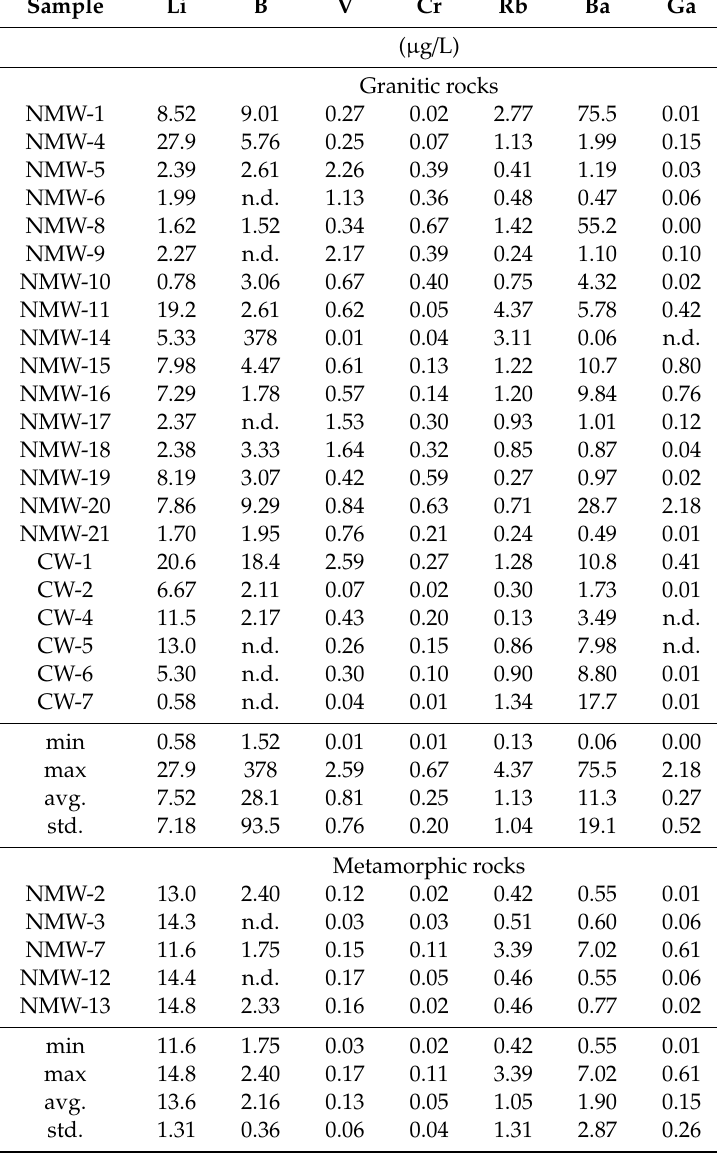
Table 3. Some trace element contents for Korean bottled water originating from groundwater underlying granitic rocks and metamorphic rocks, respectively. Functional water (FW) and desalinated seawater (DW) were not shown because the samples were not closely related to lithological